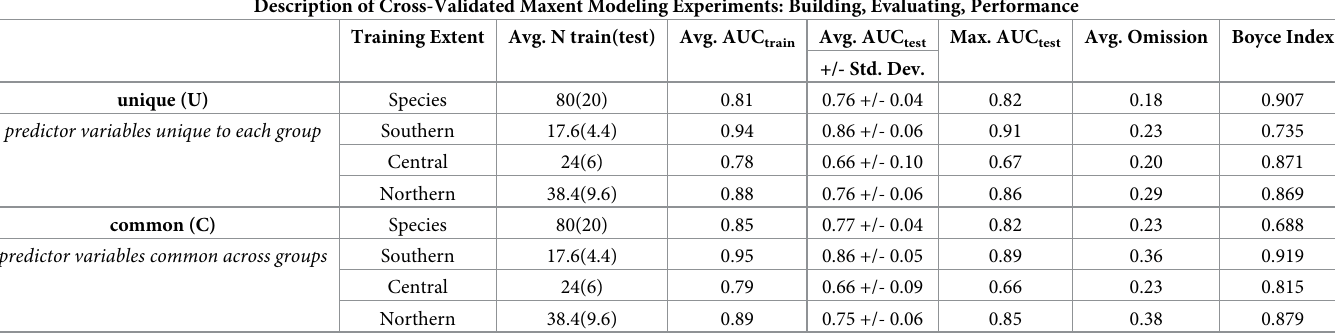
Table 1. Description of cross-validated Maxent modeling experiments. Description of Cross-Validated Maxent Modeling Experiments: Building, Evaluating,